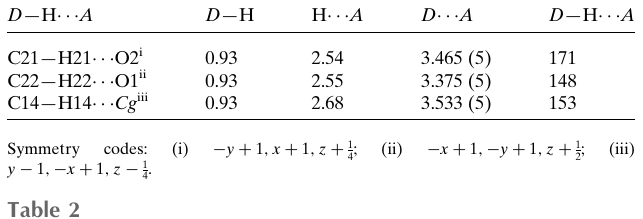
Table 2 Experimental details.